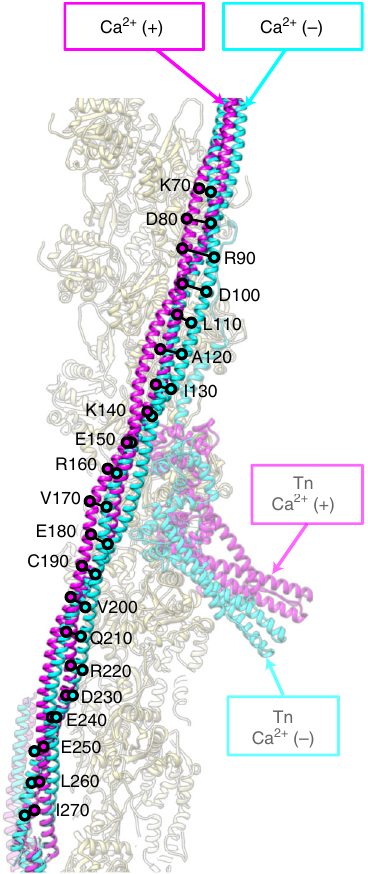
Fig. 4 Variation in the shift of Tm coiled coil on the surface of actin fi lament. Tm coiled coils are colored blue and magenta for the Ca 2 + free and bound states, respectively. Positions of corresponding C α atoms are indicated by open